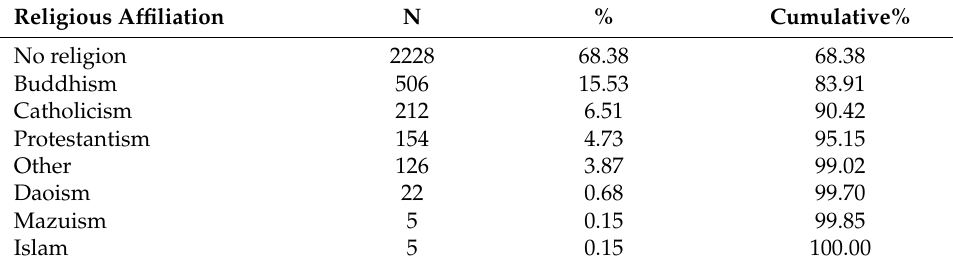
Table 2. Types of Religious